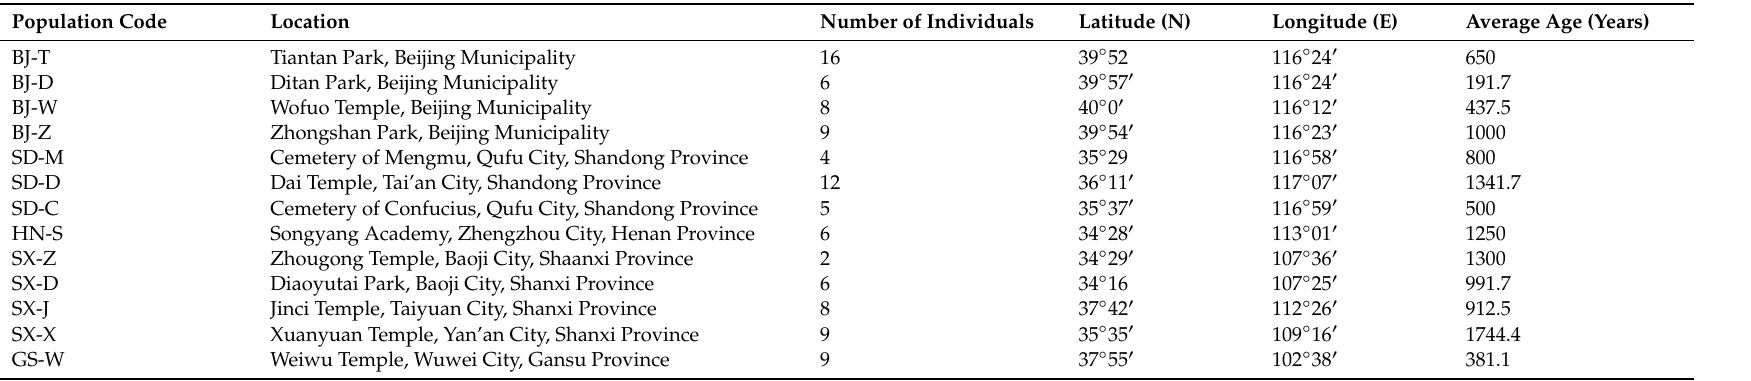
Table 3. Locations of ancient Platycladus orientalis